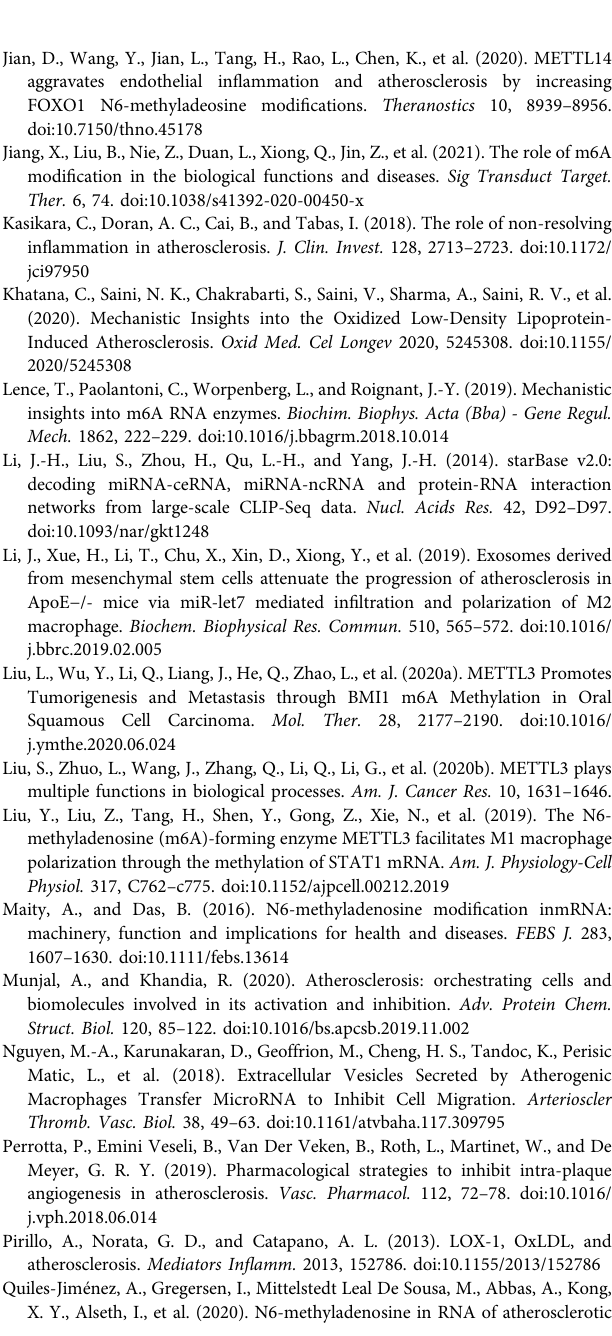
SUPPLEMENTARY TABLE 4 | StarBase-predicted mRNAs that had a possibility to bind with METTL3. SUPPLEMENTARY TABLE 5 | Common genes in Supplementary Tables S1, S2, and S4 . SUPPLEMENTARY FILE 1 | The formula of H10540 feed. SUPPLEMENTARY FIGURE 1 | HUVECs were treated with ox-LDL (10 μ g/ml) for 24 h. Next, protein levels of JAK2, STAT3 and p-STAT3 were measured by